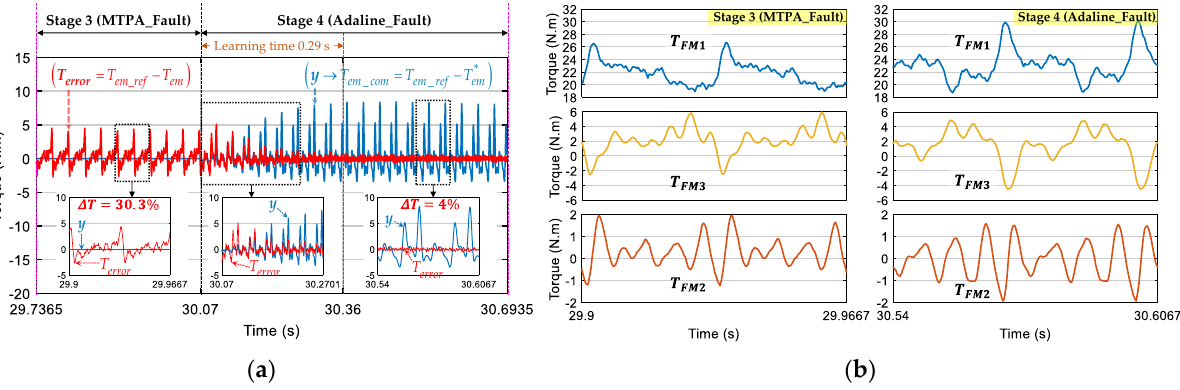
Figure 10. (Experimental result) Switch from stage 3 to 4 when phase A is opened at 300 rpm: ( a ) elimination of T error with the proposed Adaline-based scheme ( η = 0.01) in stage 4; and ( b ) torques of fictitious machines ( T FM 1 , T FM 2 , T FM 3 ) in one electrical period.